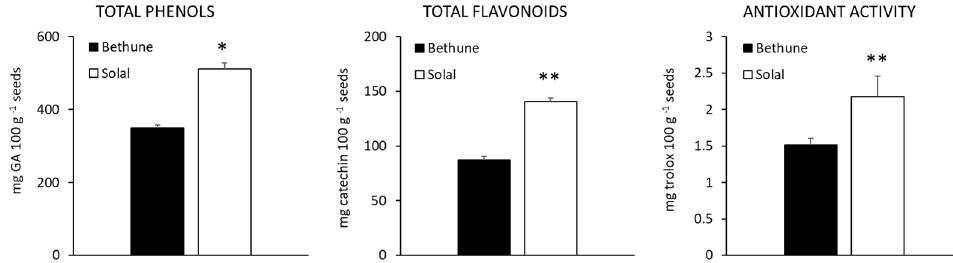
Figure 1. Concentration of total phenols (mg gallic acid equivalents 100 g − 1 seeds) and total flavonoids (mg catechin equivalents 100 g − 1 seeds), and antioxidant activity (mg trolox equivalents 100 g − 1 seeds)